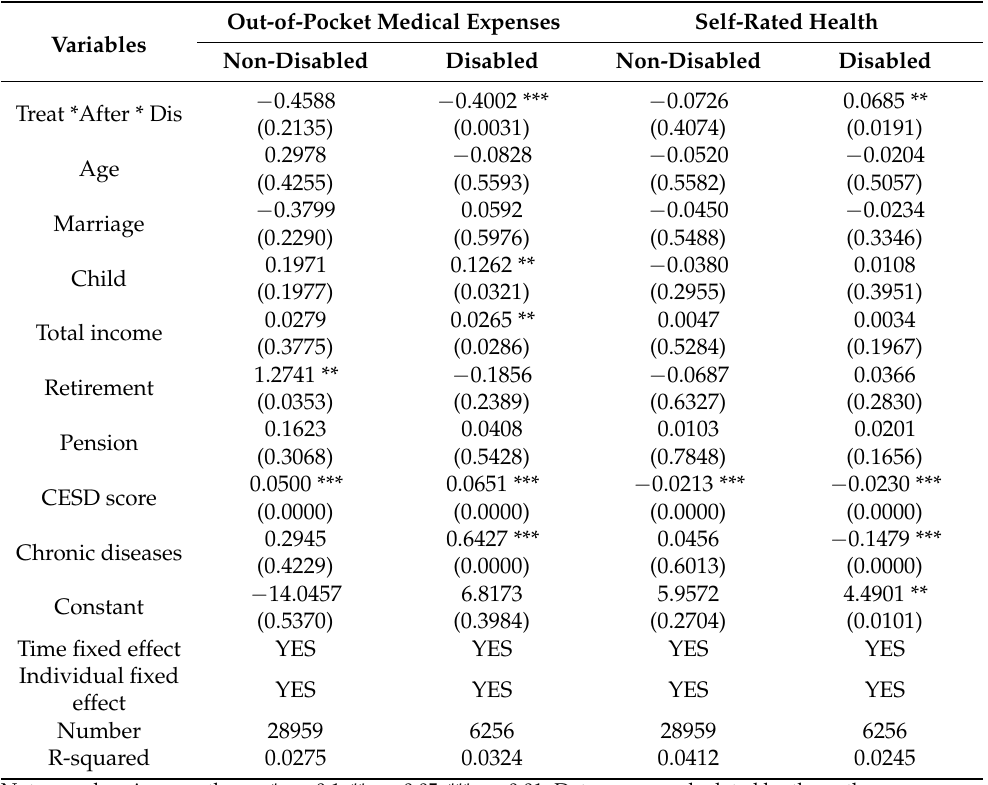
Table 9. Disabled and non-disabled heterogeneity